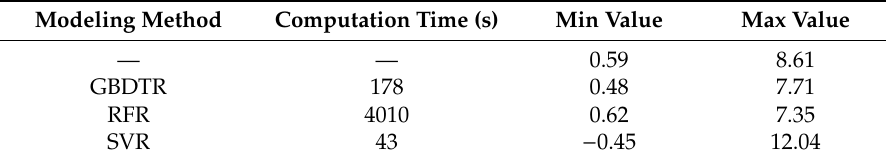
Table 3. Statistical information of the UAV-borne image inversion based on the di ff erent models in the Shahu Port